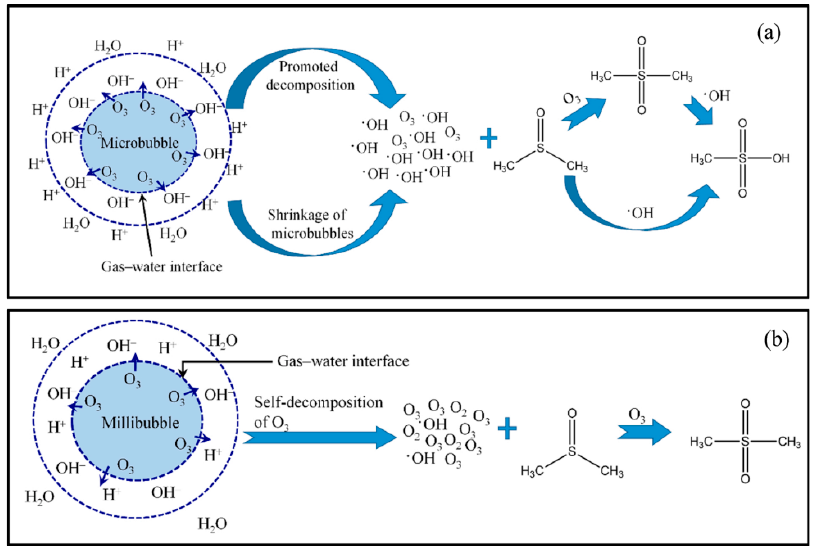
Figure 5. Proposed mechanisms of DMSO degradation by ( a ) OMBs and ( b ) OMLBs [12]. (DMSO— dimethyl sulfoxide; OMBs—ozone microbubbles; OMLBs—ozone millibubbles). Reprinted with permission from Ref. [12].